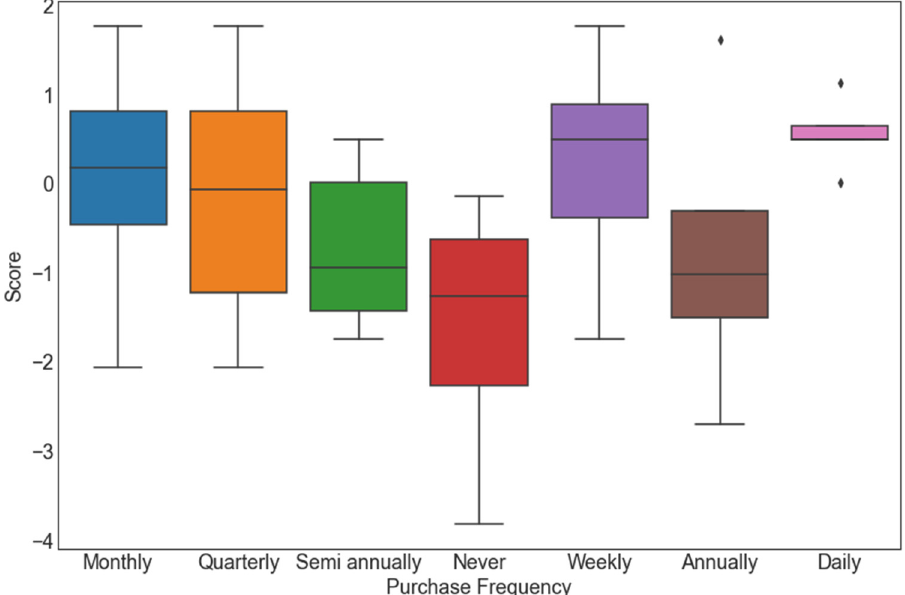
Figure 10. Standardized e-commerce awareness score distribution by purchase